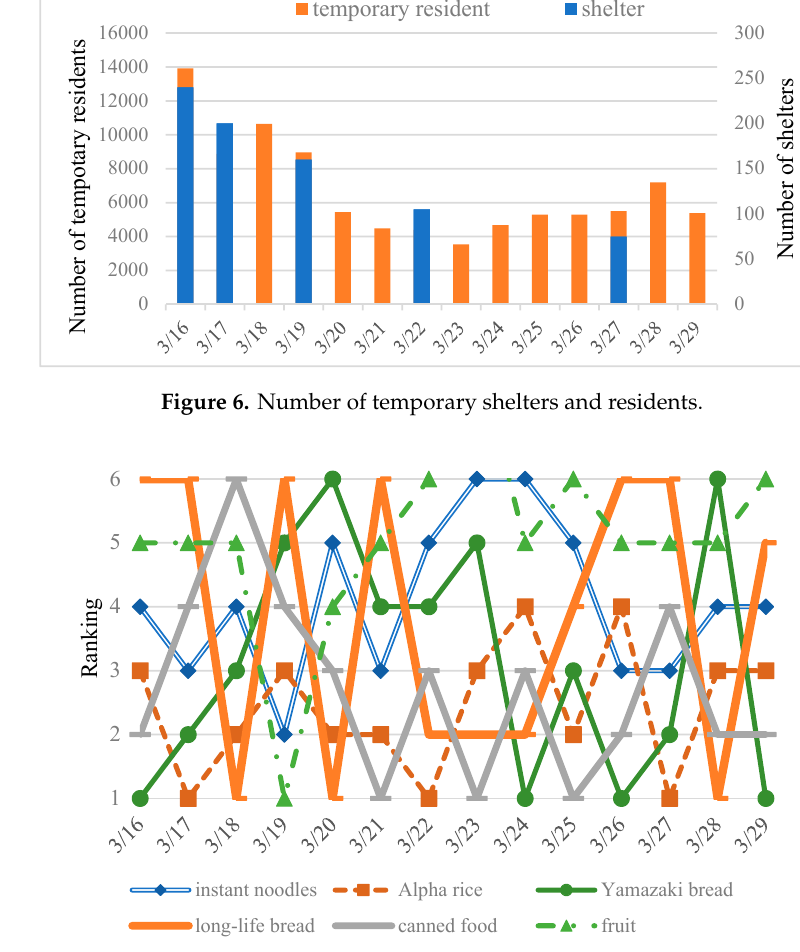
Figure 7. Temporal distribution of primary supplies over 14